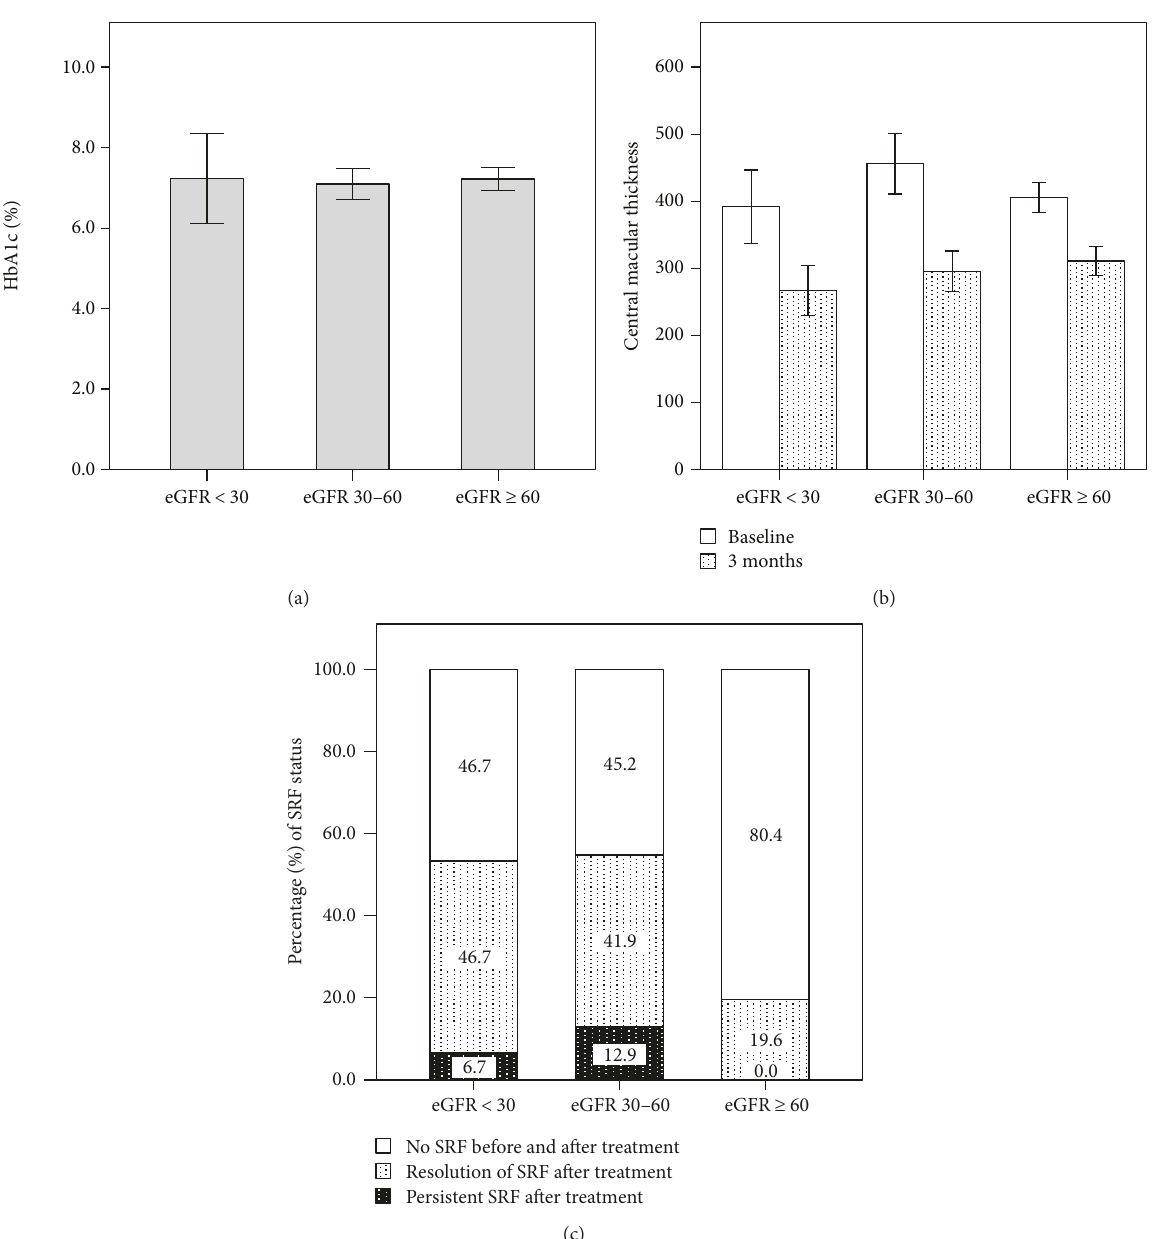
Figure 1: Presentation of clinical parameters in relation to di ff erent kidney functions with eGFR < 30, between 30 and 60, and ≥ 60. The di ff erences among the three groups were not statistically signi fi cant in (a) HbA1c level ( p = 0 90 , GLM/ANOVA) and (b) central macular thickness before and after treatment ( p = 0 051 and 0.17, resp., GLM/ANOVA). Data were in mean ± 2SE. In (c), poorer kidney function was associated with the presence of subretinal fl uid before and after treatment ( p = 0 001 and 0.04, resp., Spearman ’ s